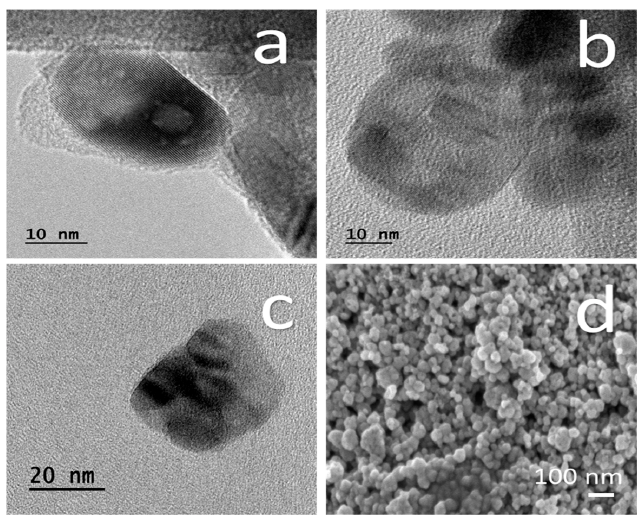
2 NPs determined by DLS.